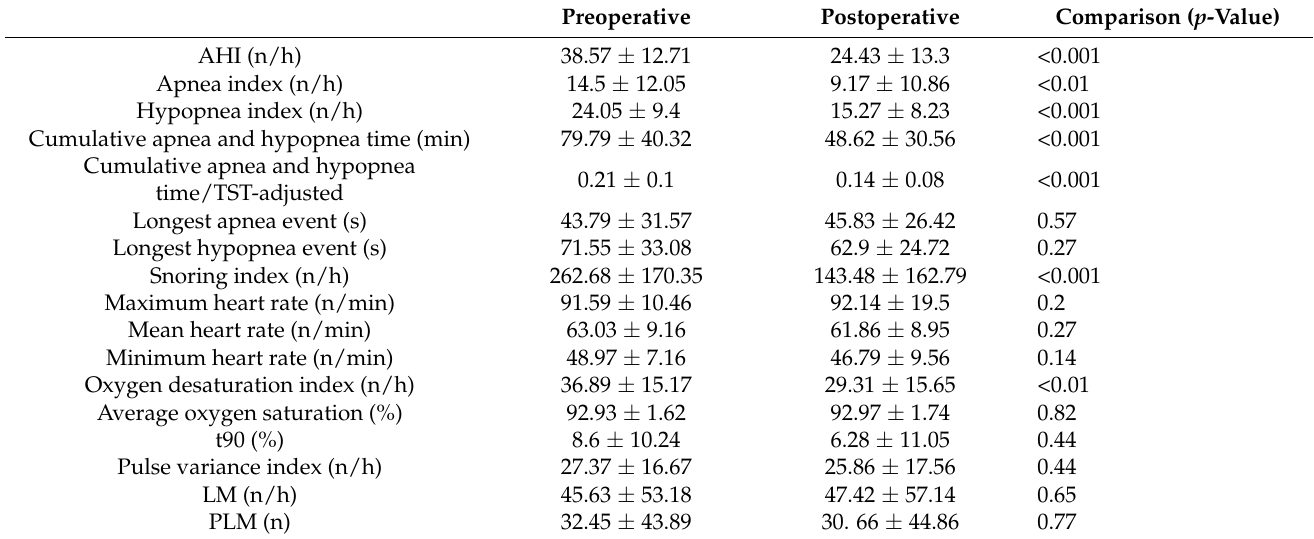
Table 1. Pre- and postoperative respiratory-associated PSG-based